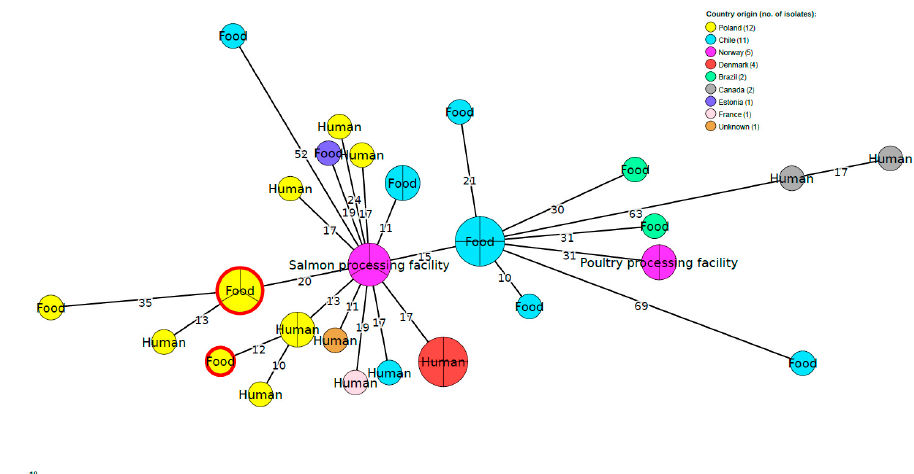
Figure 3. MST based on the cgMLST profiles of 4 L. monocytogenes of SL8 identified in the present study together with 35 SL8 strain profiles publicly available (listed in Table S2). cgMLST are represented by colored circles where size is proportional to the number of isolates. Numbers on the branches show alleles differences between neighboring nodes. Circles with red rim represent L. monocytogenes strains from the present study.